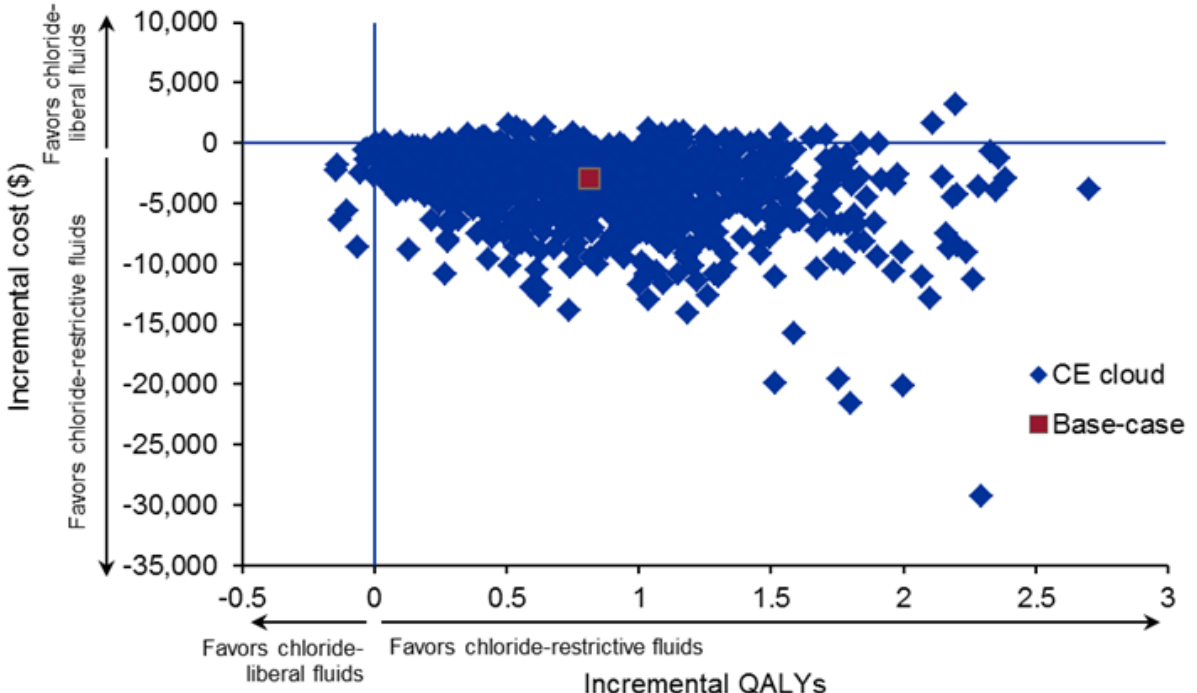
Figure 5. Probabilistic Sensitivity Analysis of Cost per QALY (1000